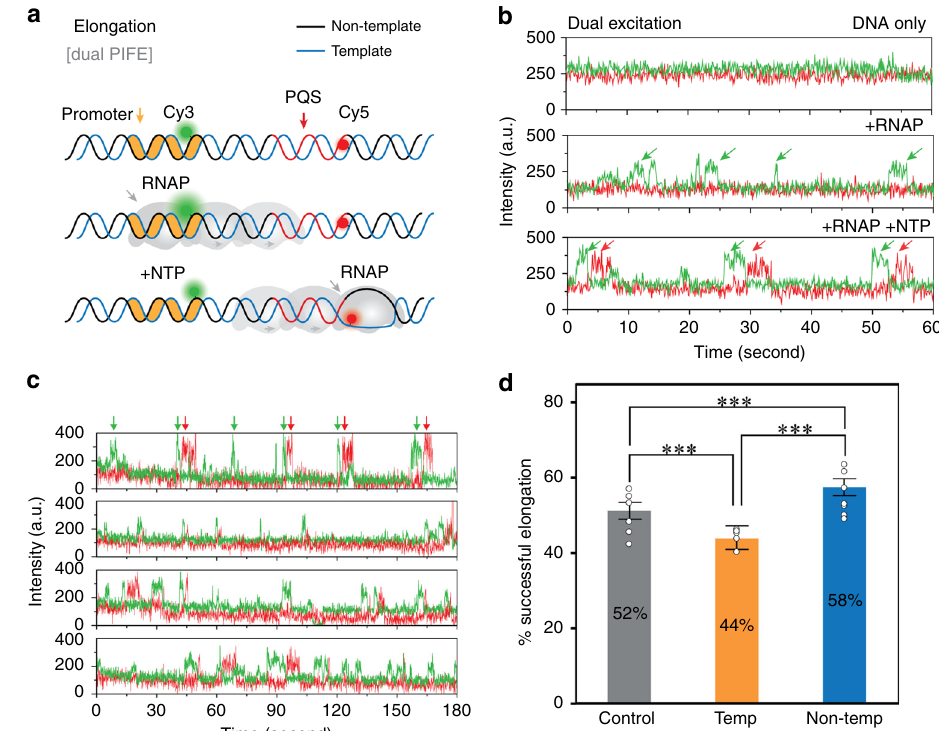
Fig. 4 PQS orientation mediates elongation events by dual-PIFE assay. a Experimental scheme of dual-PIFE assay. The two dyes are separated out of FRET-sensitive distance. Dual excitation of 532 nm (green) and 641 nm (red) lasers are applied simultaneously. b Trace examples demonstrate the events of single PIFE (green only) and dual-PIFE (green and red). c Examples of both single- (green) and dual-PIFE signal (red) that can exist in the same trace, indicating elongation is not always successful. d The fraction of successful elongation event is calculated by counting the number of dual-PIFE events out of total events. Data are presented as mean ± SEM of n = 7 independent experiments. Statistical signi fi cance, *** P < 0.001 was performed by one-sided Pearson ’ s χ 2 -test. Exact mean and P -value are provided in Supplementary Table